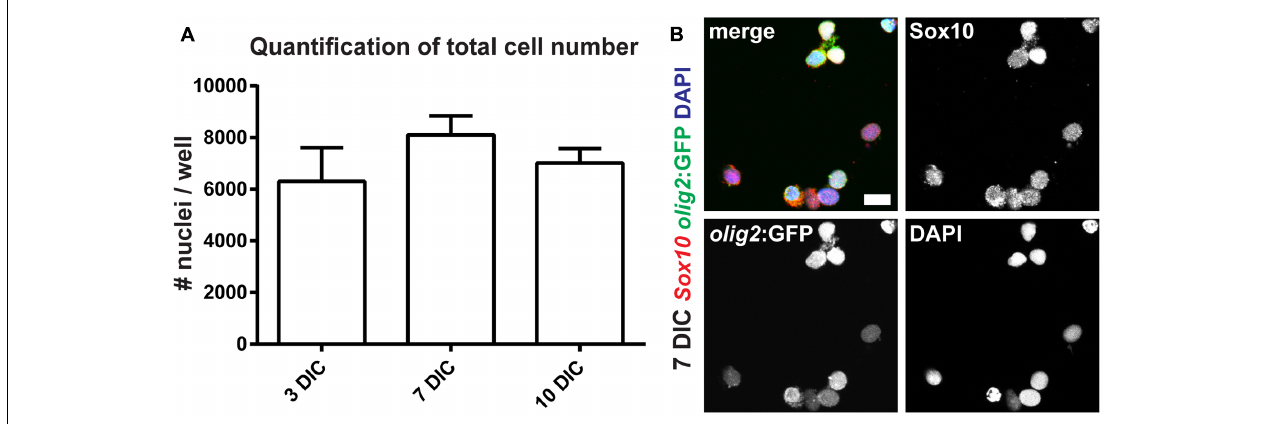
FIGURE 6 | Oligodendrocyte progenitor cells can be maintained as monocultures. (A) OPC numbers are stable over the course of 10 days in culture (DIC). (B) The vast majority of olig2 :GFP cells co-express Sox10, identifying them as OPCs; scale bar represents 10 µ m.